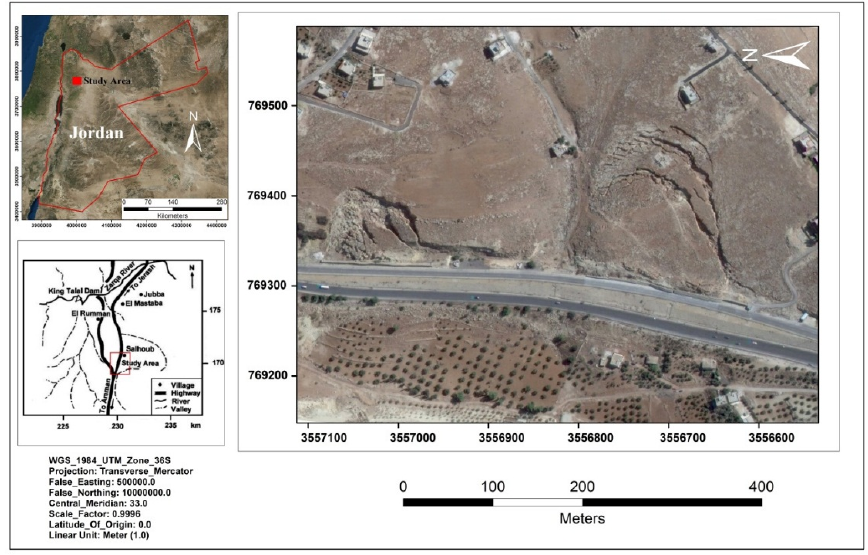
Figure 1. Location of study area and distribution of the landslides.